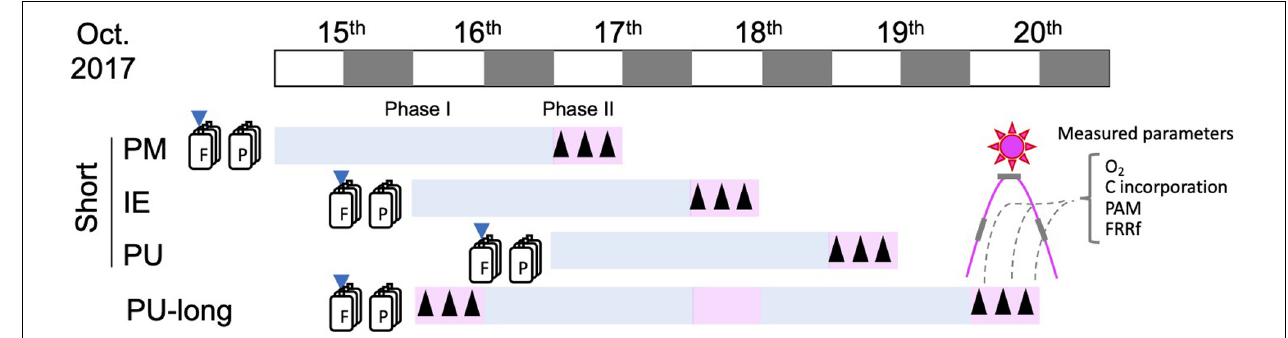
FIGURE 2 | Schematic diagram of the experimental set up. White and black boxes show light and dark hours of the day. Downward arrows show nutrient and pH amendment, F and P represent Future and Present scenario, respectively. Upward arrows show the timing of measurements.